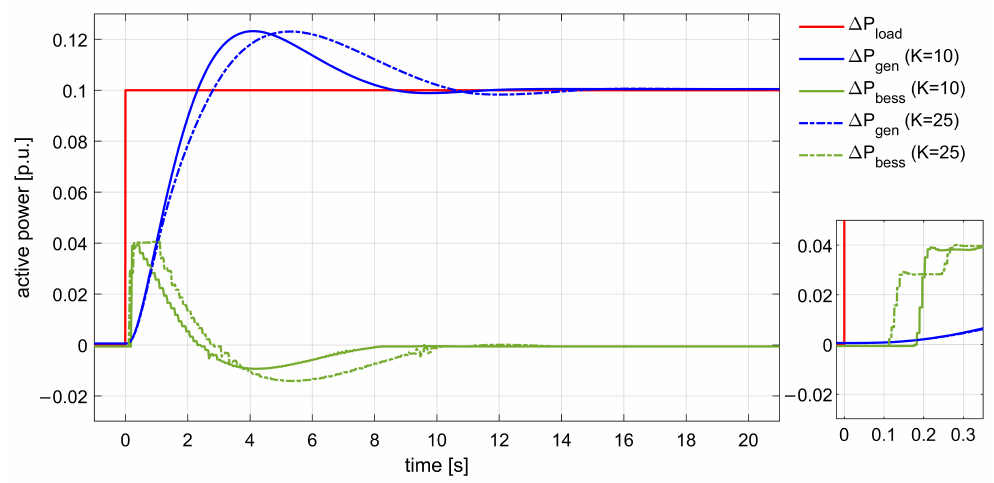
Figure 7. Ideal controller: BESS active power response with different gain K